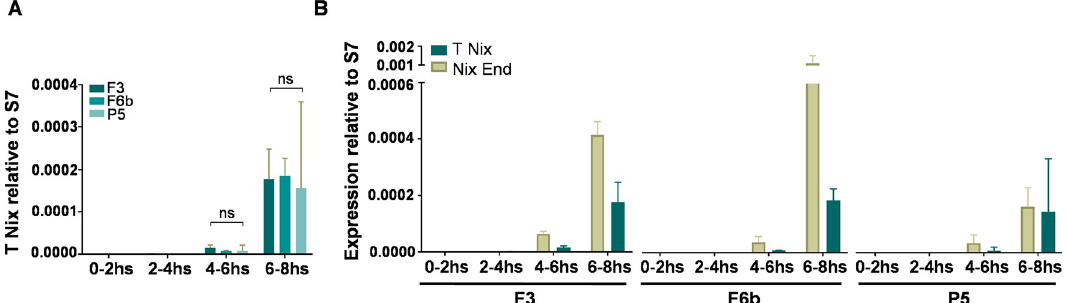
Fig 8. Transgenic and endogenous Nix expression profile in transgenic mosquitoes. Comparison of accumulated transgenic Nix transcript (A) and quantification of accumulated transgenic Nix transcript and Nix endogenous (B) from embryos collected 0-2h, 2- 4h, 4-6h, 6-8hs after being laid from F3, F6b, and P5 transgenic lines. Columns represent the mean values and bars show the standard deviation of at least two independent experiments containing at least 50 embryos each. One-way ANOVA test was used to determine the statistical significance ( B ); ns: P > 0.05; ��� : P <